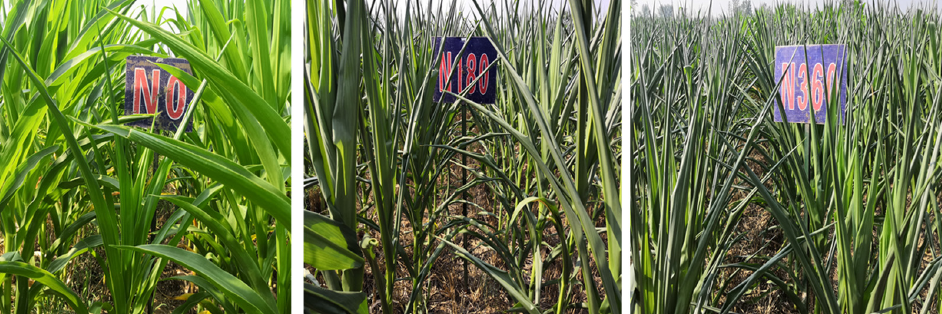
Figure 2. ( a ) Aerial drone photography of maize under nondrought stress conditions (left) and under drought stress (right); ( b ) leaf morphology of the cultivar Denghai 605 (DH605) subjected to drought stress with di ff erent nitrogen (N) levels.